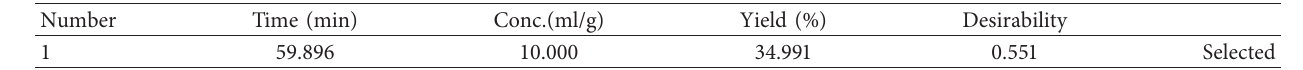
Table 7: Optimization at minimum time, concentration, and high yield.